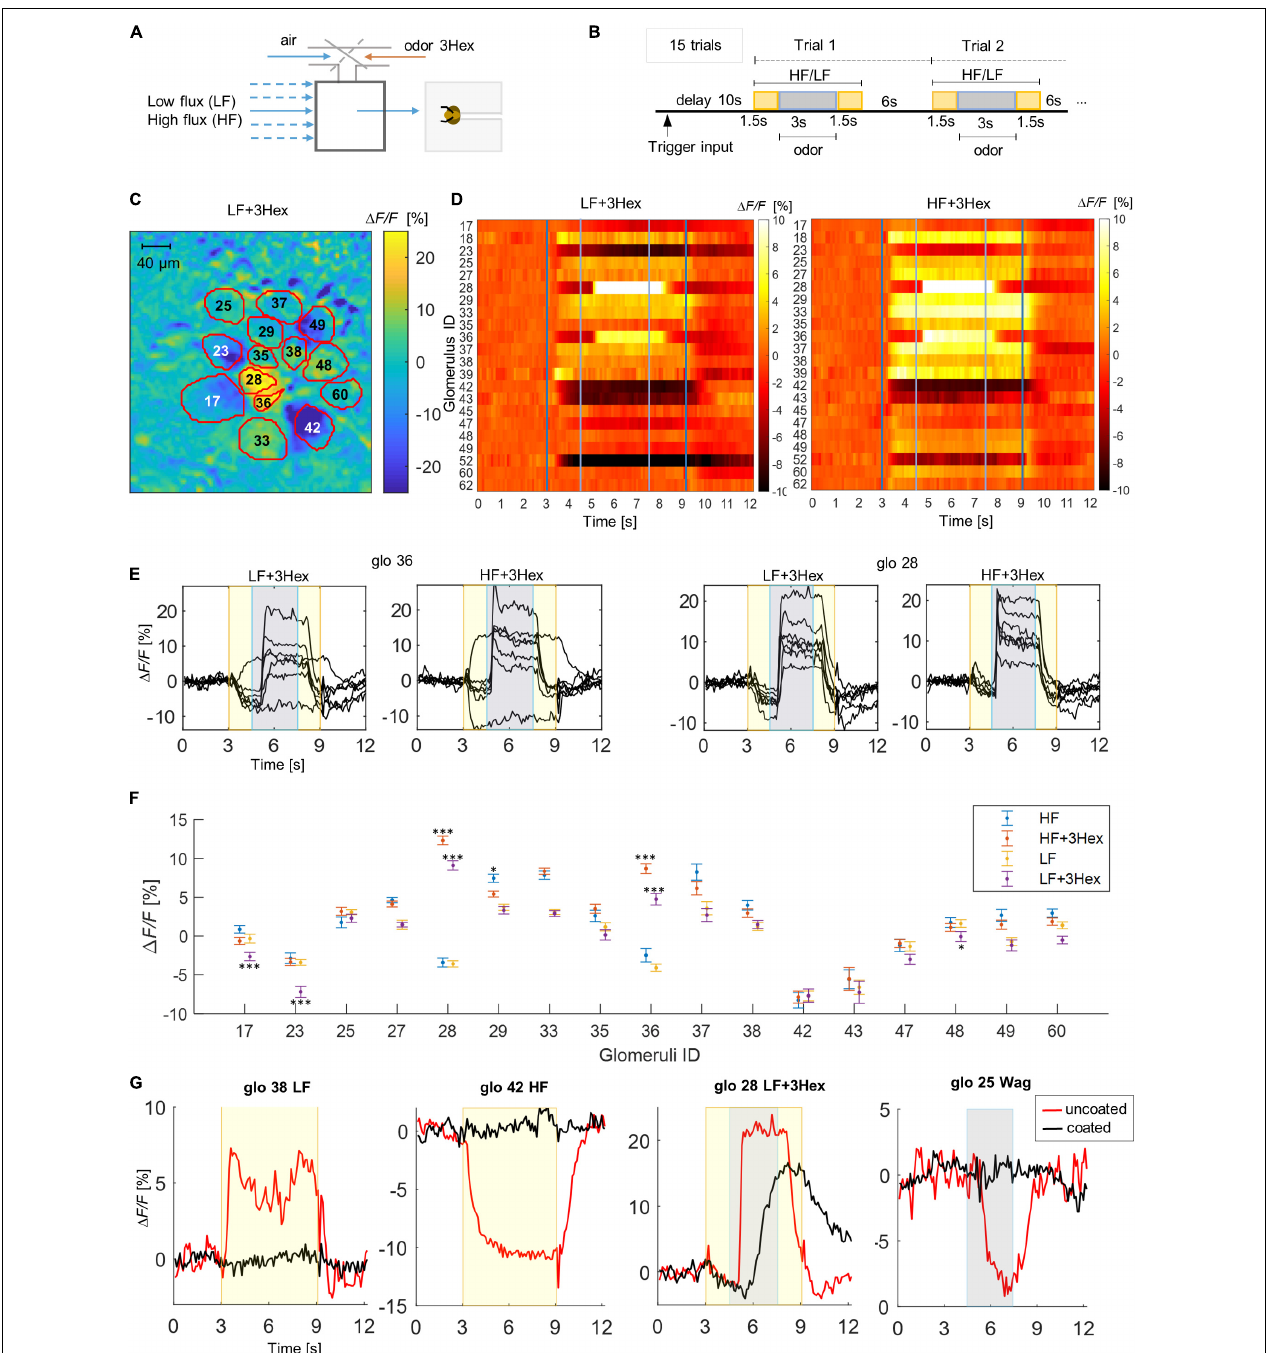
FIGURE 2 | Response patterns to mechanical and odor stimuli. (A) Scheme of the setup where either clean air or 3-hexanol (3Hex) is injected into the carrier flux. (B) Scheme of the stimulation protocol: To the airflow stimulus starting after 10 s (yellow area), the 3-Hex odor stimulus is added after another 1.5 s lasting 3 s (gray area), interstimulus interval 6 s. (C) Relative fluorescence change in the imaging plane during the low air flux plus odor stimulus (LF + 3Hex), outlines and labels show the identified glomeruli. (D) Heatmaps show subject-averaged responses of all imaged glomerulus to LF and HF delivered after 3 s and air plus odor after 4.5 s. (E) Temporal response curves of the two glomeruli (28,36) that showed responses to the odor stimulus. Shown are responses of the seven different bees averaged across the 15 trials. Yellow areas mark the air only periods, gray boxes the air plus odor periods. (F) Mean values and Standard errors across bees of the glomerular response amplitudes during the central 3 s of a stimulus with and without odor (blue: high flux only, red: high flux + 3-Hexanol, yellow: low flux only, violent: low flux + 3-Hexanol). Significant differences between air only and air + odor stimuli are marked with ∗ p < 0.05, ∗∗∗ p < 0.001. Full statistical results are shown in Supplementary Table 3 . (G) Temporal response curves of selected glomeruli to weak flow (LF), HF, weak flow + odor (LF + 3Hex), and waggling (Wag) for bees with antennae coated with fluid silicon (black) and uncoated antennae (red).